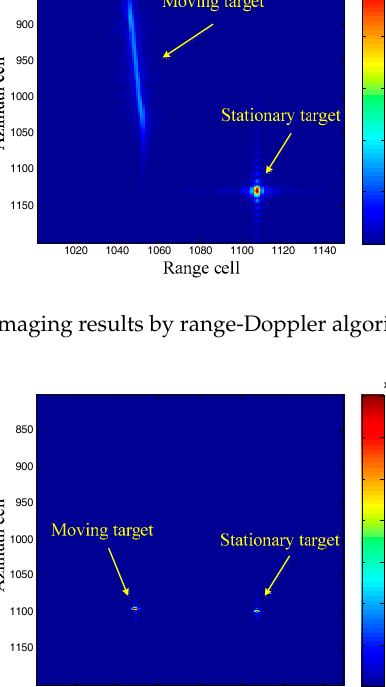
( b ) Figure 4. Doppler rate estimation comparison results. ( a ) estimation accuracy comparison; ( b ) computational complexity comparison.